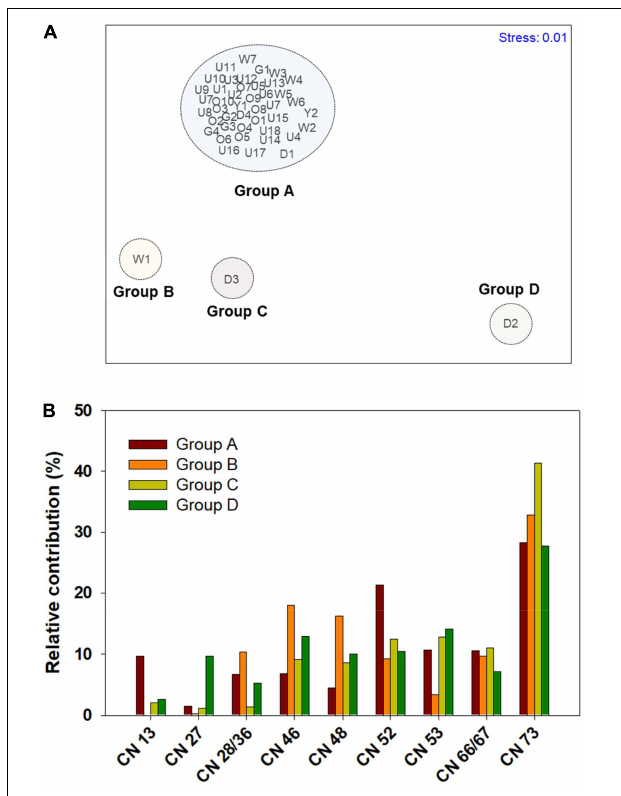
FIGURE 5 | (A) Plot of non-parametric multidimensional scaling ( n MDS) ordination for polychlorinated naphthalene (PCN) congeners in sediment from industrialized bays and their surrounding rivers and streams of Korea. (B) Comparison of relative congener profiles of PCNs for each group (Groups A, B, C, and D) clustered by n MDS